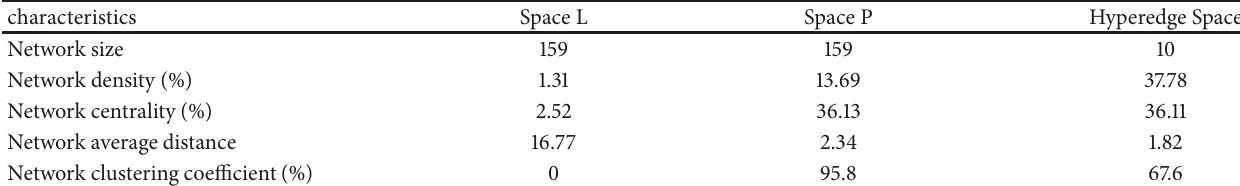
Table 2: Spatial characteristics of the complex network of Nanjing